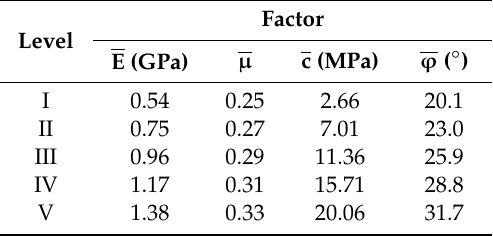
Table 3. Orthogonal experimental design table of overlying